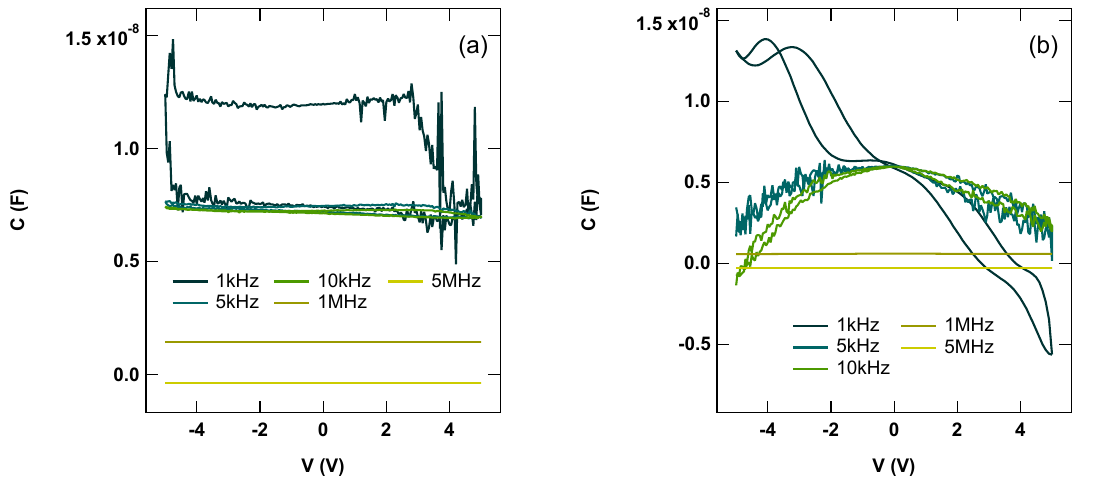
Figure 5. The C vs. V curves of the ITO / ReO 3 @ReS 2 / Al in the frequency range of 1 kHz–5 MHz for ( a ) standard and ( b ) short-circuited devices. In ( b ), the C-V curve at a scan frequency of 1 kHz was fitted with a polynomial function (original data can be found in Figure S13). Higher resolution C - V curves acquired at frequencies from 1 kHz to 5 MHz ( a ), and at 1 and 5 MHz ( b ) are shown in Figure S14. Sweeping voltage range: ± 5 V, and I cc : 1 × 10 − 2 A.